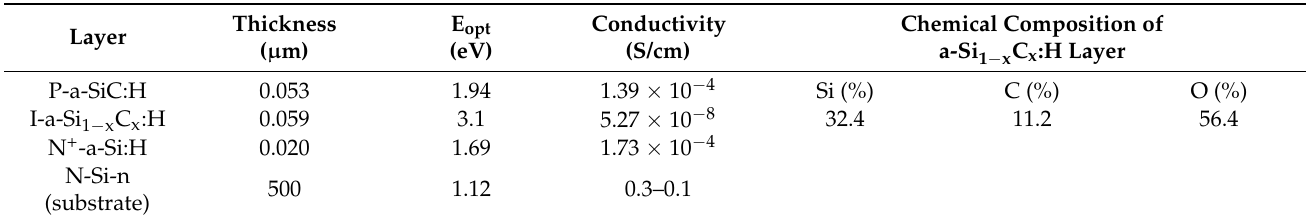
Table 2. Physical properties of each layer of the PIN and PIN+N structure and chemical composition of the active layer.